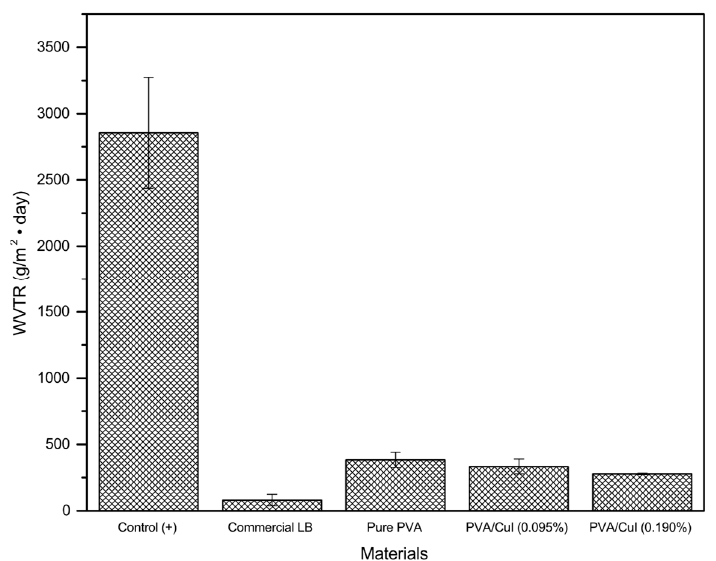
Figure 12. Drying time of film compared with a commercial liquid bandage (LB): ( a ) content of PVA; ( b ) PVA composed of CuI suspension.